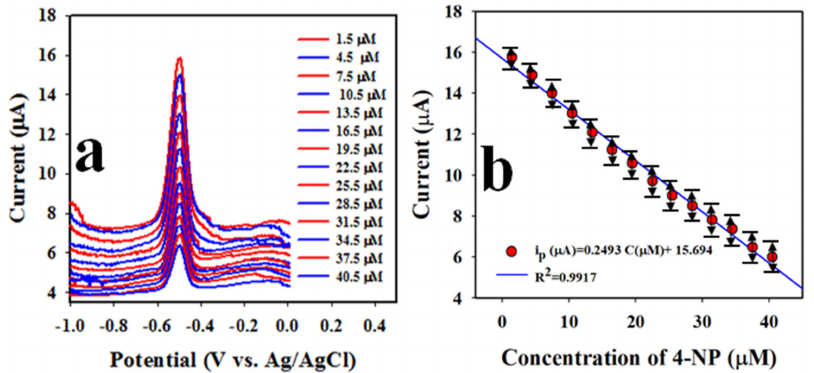
Figure 9. Detection of target analyte with Pt − NPs − embedded PPy − CB@ZnO NCs/GCE; ( a ) the resulted DPV analysis of 4 − NP at 7.0 pH buffer and ( b ) calibration of 4 − NP sensor obtained from current versus concentration of 4 − NP.